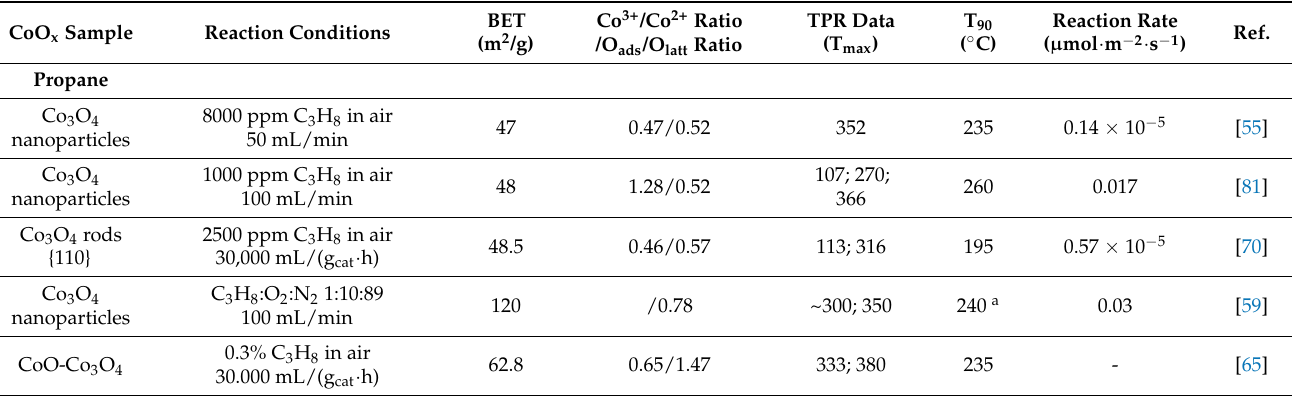
Table 1. Propane and toluene total oxidation over Co 3 O 4